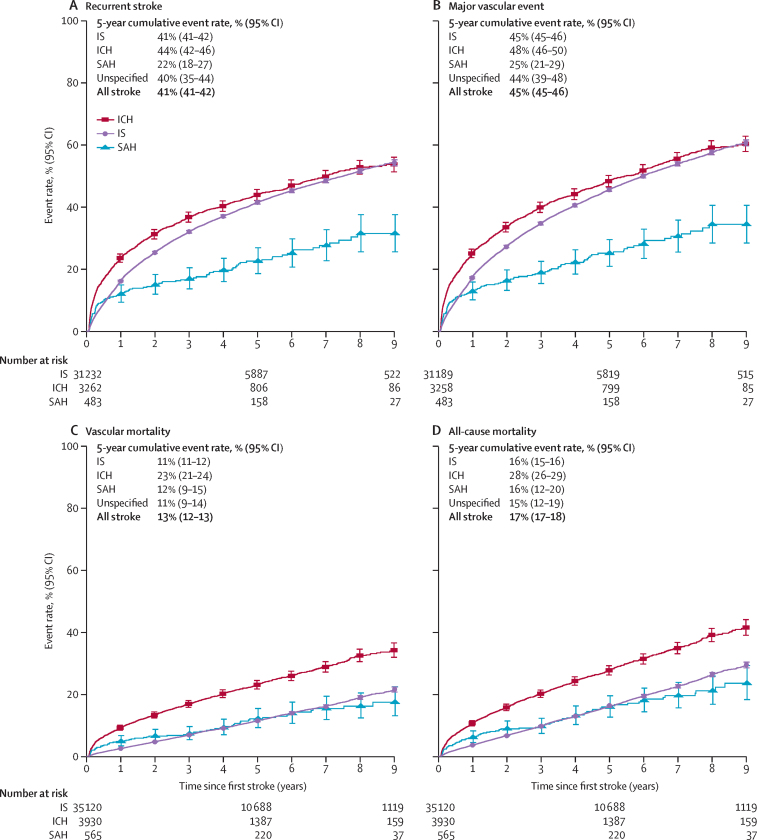
Estimated cumulative event rates of recurrent stroke, major vascular events, vascular mortality, and all-cause mortality from 28 days after first stroke of different typesPlotted lines indicate the cumulative incidence, starting at the date of first stroke. Whiskers indicate 95% CIs. Deaths from any cause were treated as competing risks. Participants experiencing an event or death within 28 days from first stroke were excluded. IS=ischaemic stroke. ICH=intracerebral haemorrhagic stroke. SAH=subarachnoid haemorrhage.